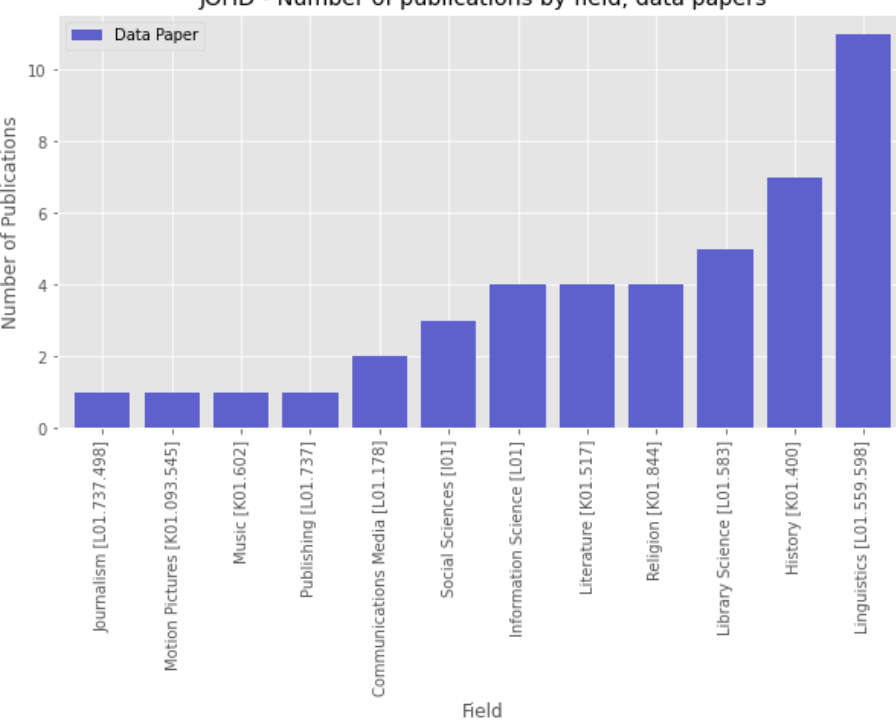
Figure A2. Number of publications by field, data papers (JOHD).